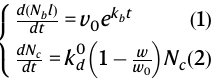
(cyan, n =71 organoids) and Matrigel-grown (magenta, n =54) organoids. d Principal component analysis of bulk RNA sequencing of Day 13 Matrigel- (magenta, n =3 independent experiments) and collagen-grown (cyan, n =5 inde- pendent experiments) organoids. e Summary of gene set enrichment analysis betweenMatrigel-andcollagen-grownorganoids,showingnormalizedenrichment scores (NES) and false discovery rates (FDR). Bars represent individual genes for a givengeneset. f Top,fromlefttoright:haematoxylinandeosinstainingofprimary tissue sections from a healthy pancreas, a Ptf1a Cre/+ ;Kras G12D/+ tumor, and a Pdx1 Cre/ + ;Kras G12D/+ ; TP53 fl / fl tumor ( n =3 technical replicates). Bottom from left to right: bright fi eld images of representative organoids at day 13, grown in collagen from wild type pancreatic ductal cells (WT PDC), Ptf1a Cre/+ ;Kras G12D/+ cells, and Pdx1 Cre/ + ;Kras G12D/+ ; TP53 fl / fl cells, all cultured in PDAC medium (see Methods) ( n =3 indivi- dual experiments). Scale bars: top, 100 µ m; bottom, 500 µ m. Fluorescence images shown are confocal slices, except for the 3D reconstruction of the Cytokeratin-7/ DAPI staining in a